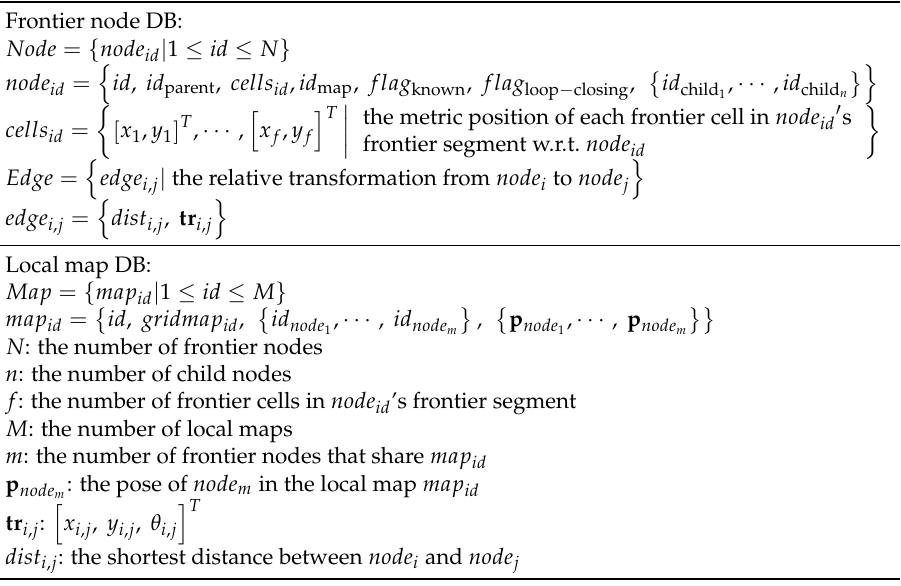
Table 1. Frontier node database and local map database of the frontier-graph